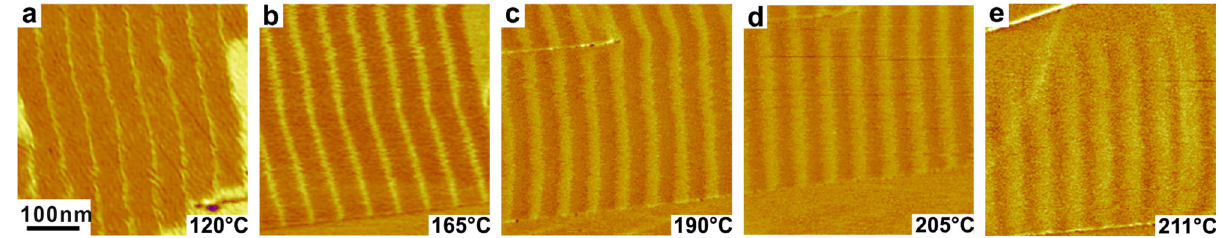
Fig. 3 Continuous melting of a C 390 H 782 monolayer on graphite. a – e Zoomed-in AFM phase images in the region marked by the black square in Fig. 2a, at temperatures from 120 to 211 °C. d =